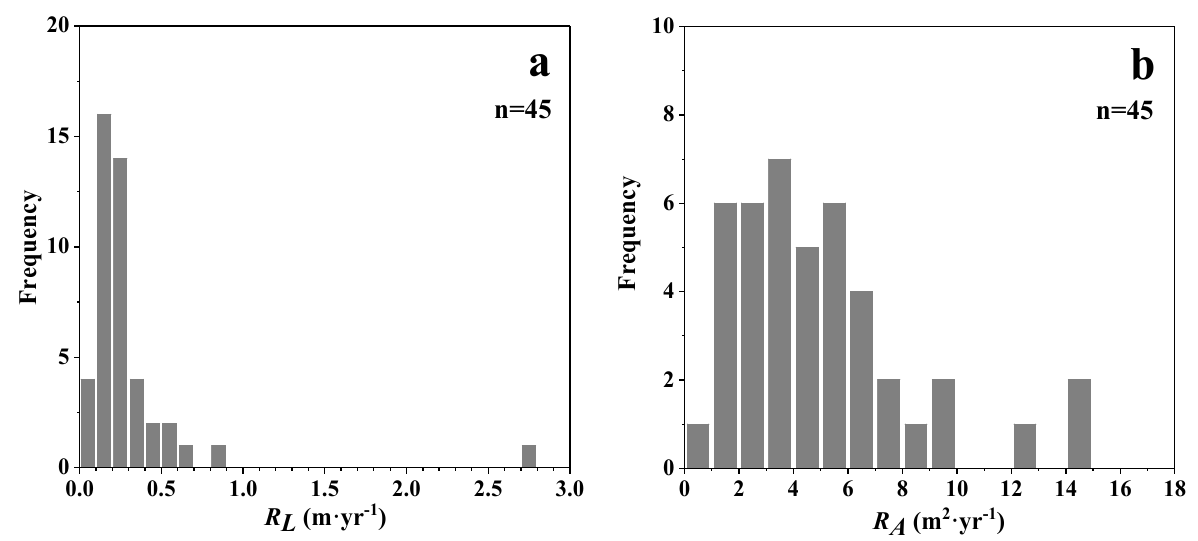
Figure 5. ( a ) Frequency distribution of linear gully head growth rates ( R L ) and ( b ) areal gully head growth rates ( R A ) for 45 growing gullies.